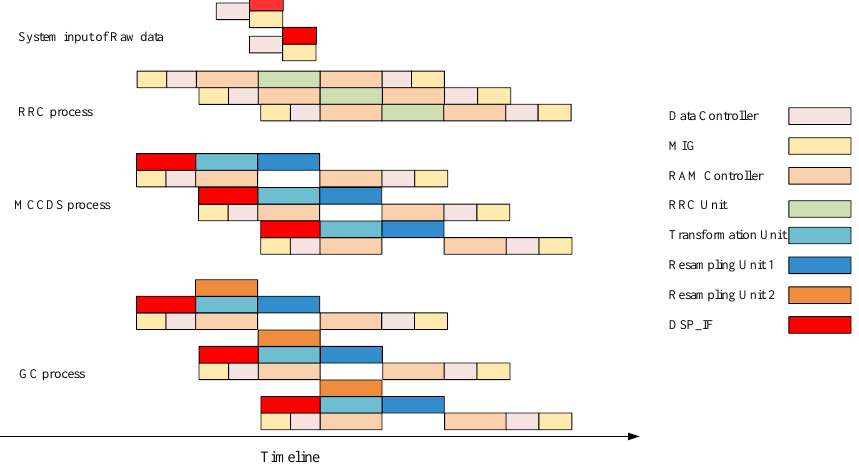
Figure 12. Processing timeline of the system.